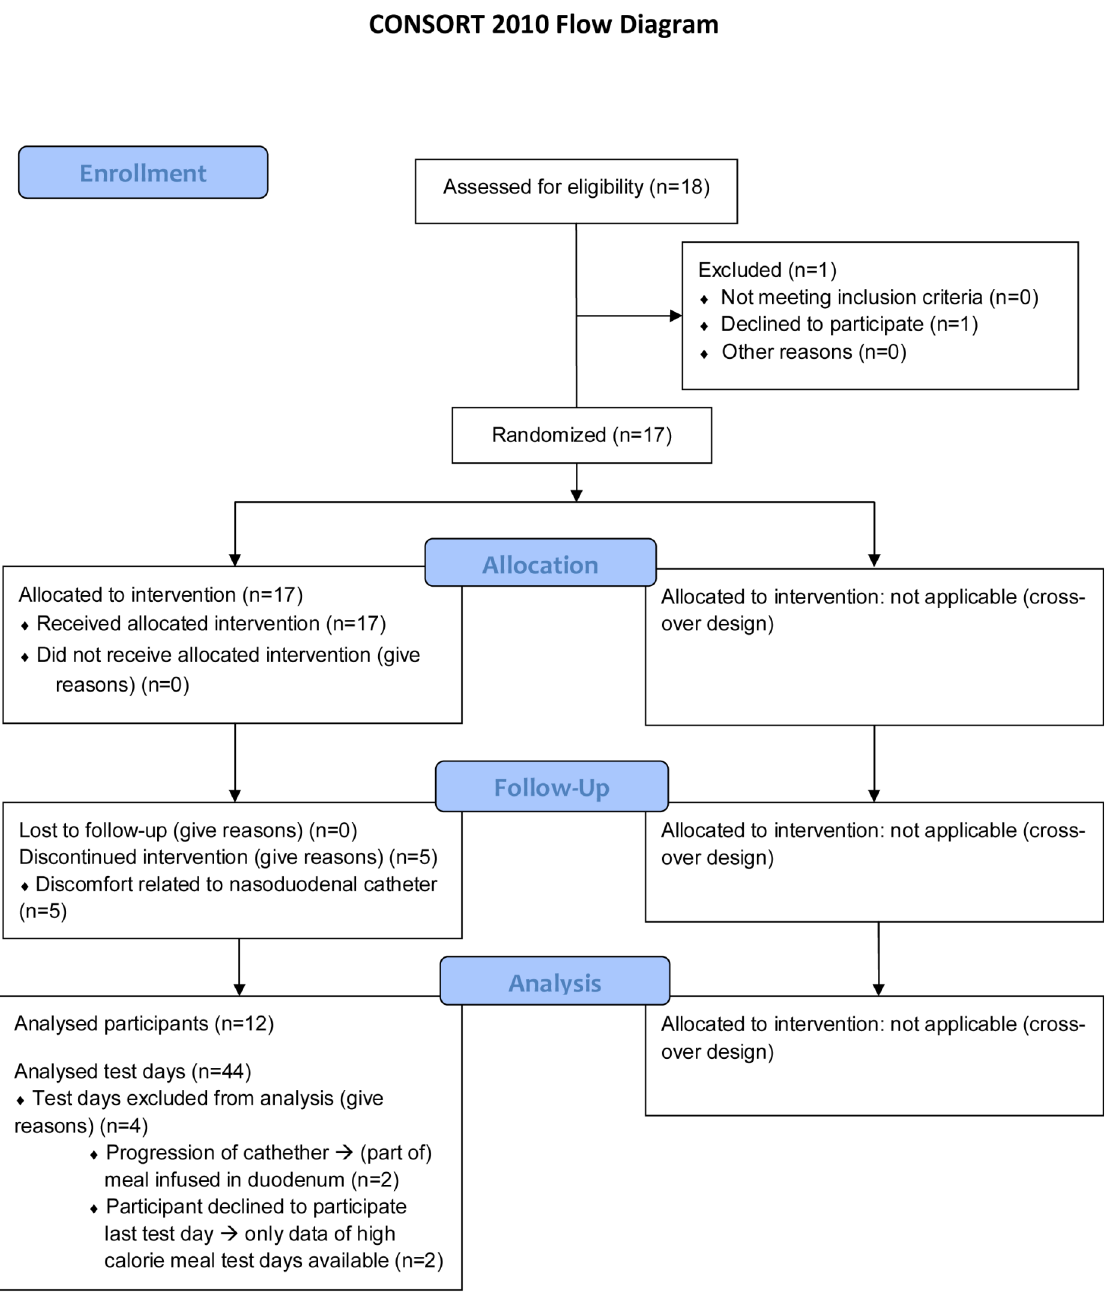
Fig 1. Consort Flow Diagram of the